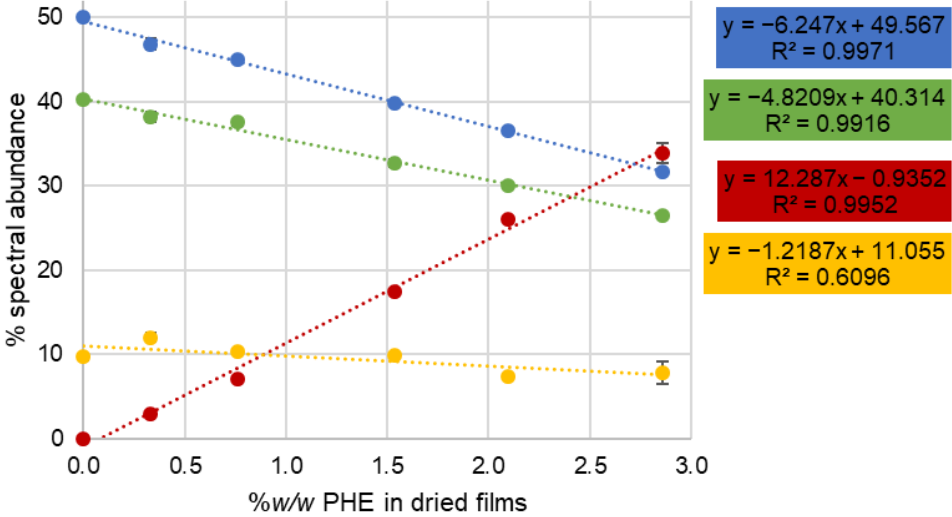
Figure 8. NCLS results with normalized abundance fraction of each component as a function of the concentration of PHE (% w / w in dried films). Red: PHE fraction, Blue: Glycerol fraction, Green: PVA fraction, and yellow: AMA fraction. Error bars represent standard error for n = 3 replicate films.